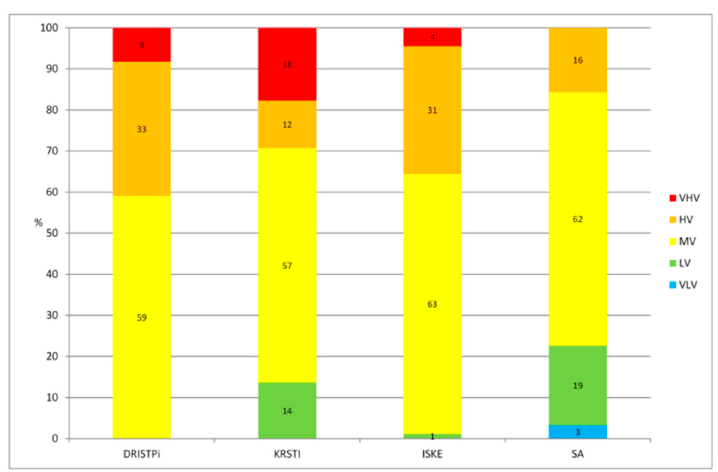
12 of 17 Figure 4. Final vulnerability maps from ( a ) DRISTPI; ( b ) KRSTI; ( c ) ISKE; and ( d ) SA. A resume of vulnerability percentages is displayed in Figure 5. Despite MV is the most remarkable class, covering most of the area, it does not match the Yucatan regional characteristics. Display of MV on coastal areas, with shallow water tables (less than 1 m of depth) and sands as soil cover, can be considered inaccurate from a theoretical basis. Results for MV are triggered by the